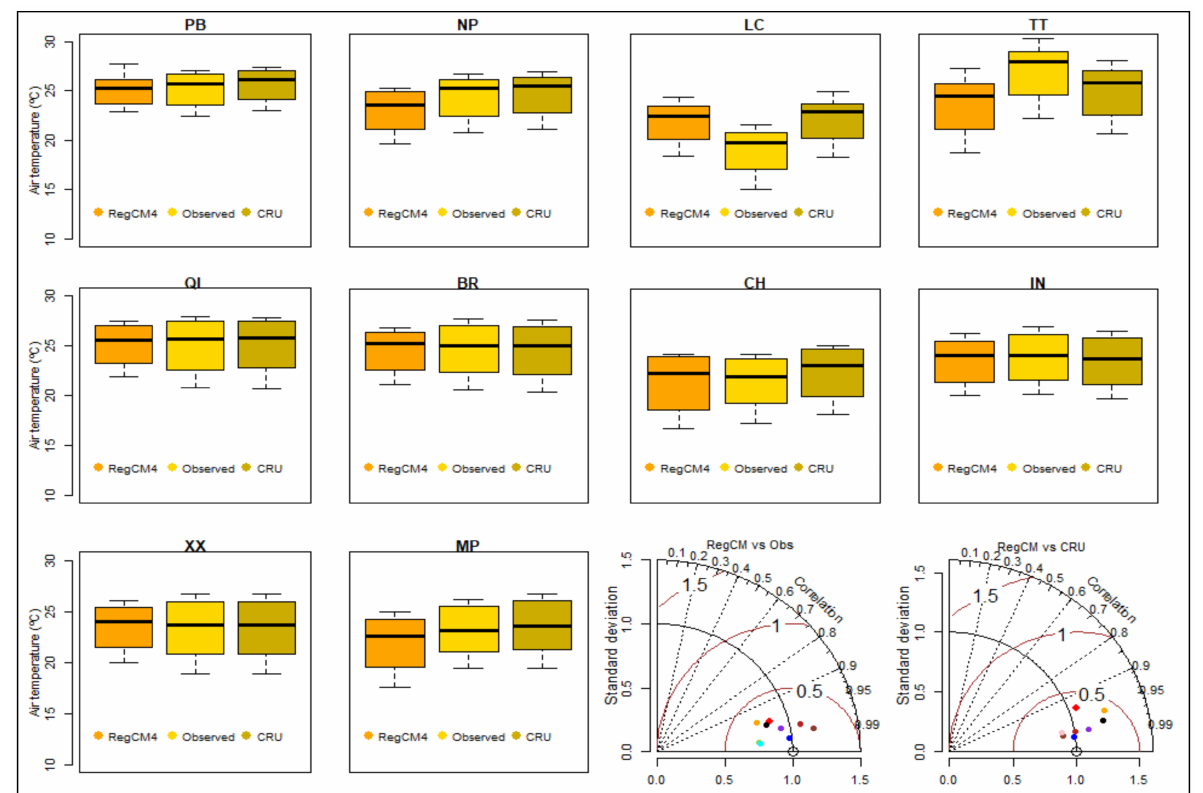
Figure 5. Boxplot diagrams for the three datasets, monthly mean of air temperature ( ◦ C) for reference period. In the lower right corner, Taylor diagrams for RegCM4 and WS (RegCM vs. Obs), CRU and WS (CRU vs. Obs). Open circle is the reference of normalized standard